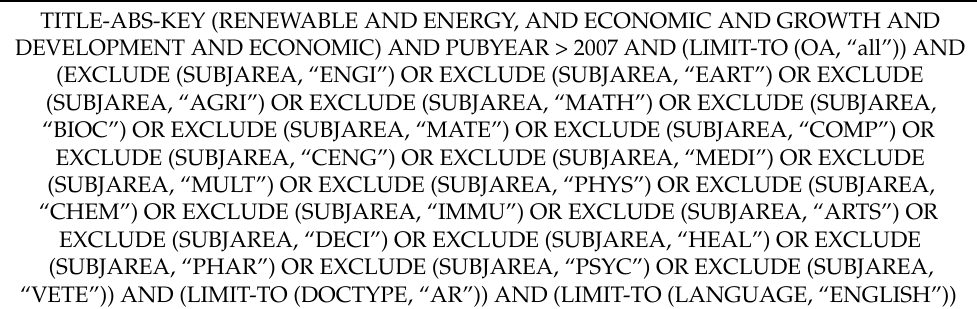
Table A1. Search Protocol. TITLE-ABS-KEY (RENEWABLE AND ENERGY, AND ECONOMIC AND GROWTH AND DEVELOPMENT AND ECONOMIC) AND PUBYEAR > 2007 AND (LIMIT-TO (OA, “all”)) AND (EXCLUDE (SUBJAREA, “ENGI”) OR EXCLUDE (SUBJAREA, “EART”) OR EXCLUDE (SUBJAREA, “AGRI”) OR EXCLUDE (SUBJAREA, “MATH”) OR EXCLUDE